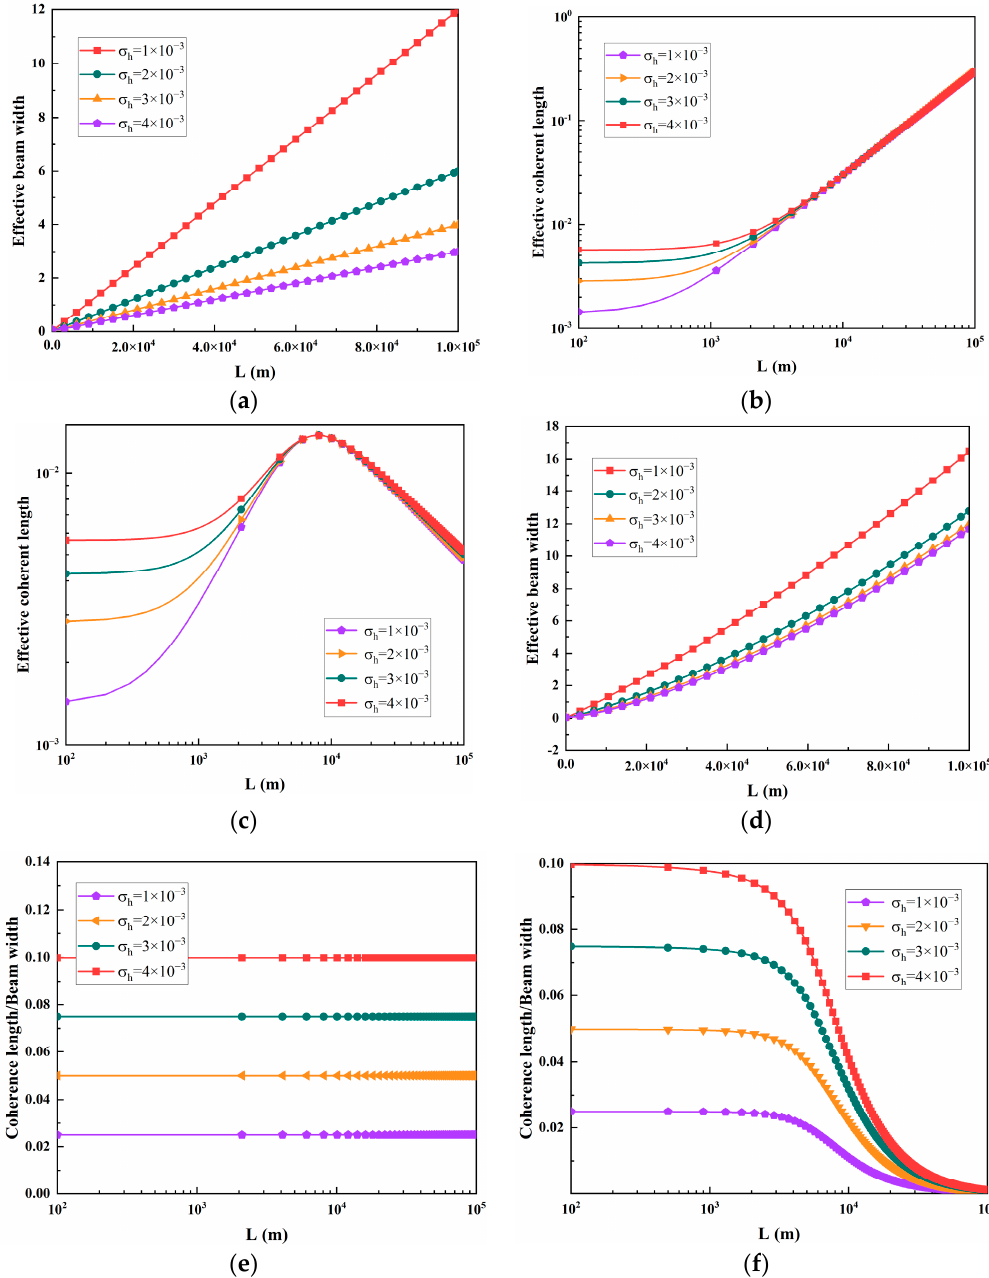
Figure 6. The influence of the coherence length of the source beam on the effective beam width, the coherence length, and their ratio in a vacuum and in turbulence. ( a , b , e ) λ = 532 nm; l 0 = 5 × 10 − 3 m; σ S = 3 cm; ( c , d , f ) λ = 532 nm; l 0 = 5 × 10 − 3 m; σ S = 3 cm; C 2 = 10 − 15 m − 2/3 .